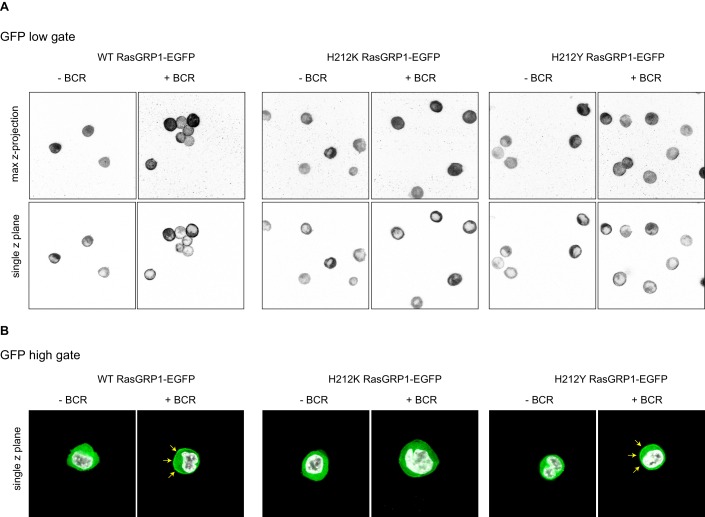
Analyses of cellular RasGRP1 localization as a function of His 212 variation.(A) Shown are representative examples of microscopy analyses of RasGRP1-EGFP low expressing DT40 RasGRP1−/− RasGRP3−/− cells without and with B cell receptor (BCR) stimulation. The top row shows the total maximum Z-projection, and the bottom row shows a single z-plane, which was used for counting. (B) Shown are representative examples of microscopy analysis of high RasGRP1-EGFP expressing cells. The signal shows localization of full length expressed RasGRP1-EGFP wildtype (WT) and mutants (His212Lys, His212Tyr), showing basal state (no stim, cytoplasmic), and upon B cell receptor stimulation (+BCR, arrows indicate plasma membrane localization).